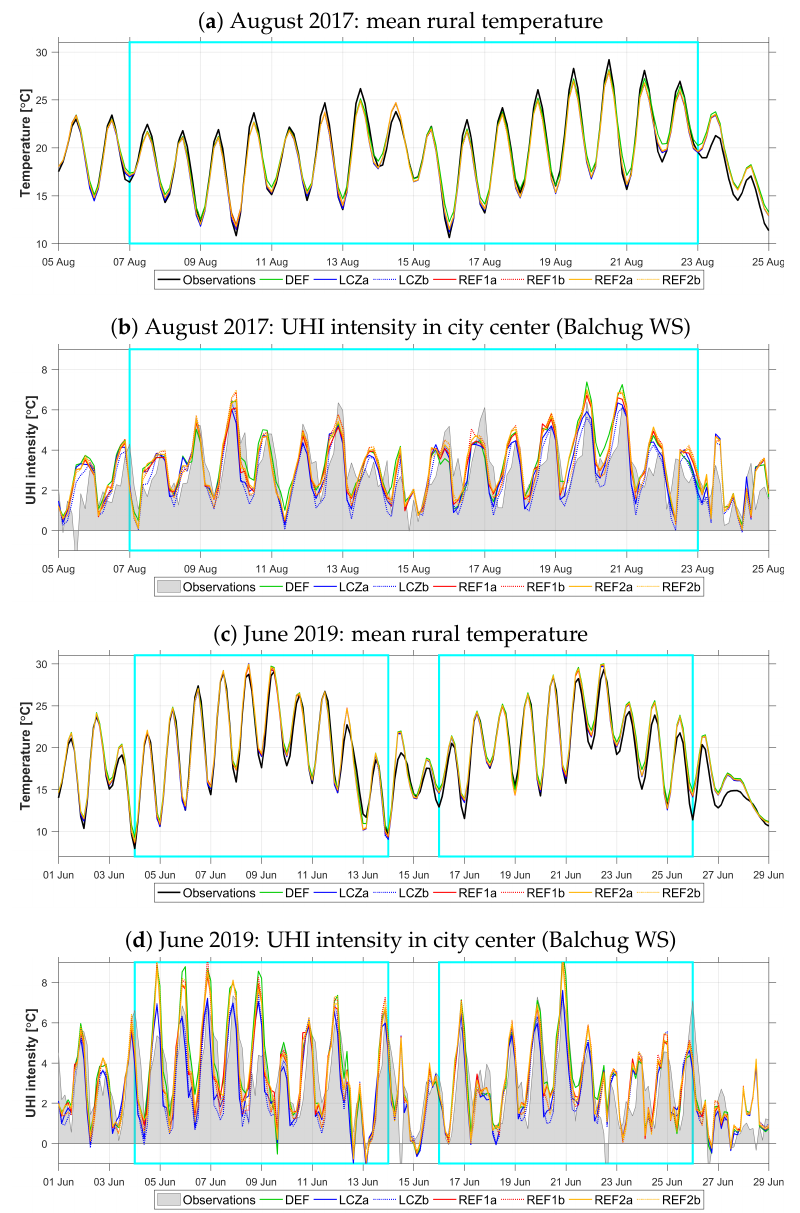
Figure 7. Modelled and observed values of the mean rural temperature ( a , c ) and urban heat island (UHII) intensity for the city center ( b , d ) for August 2017 ( a , b ) and June 2019 ( c , d ). The mean rural temperature is averaged over 9 selected rural stations around Moscow, and UHI intensity is defined as the departure from this mean rural temperature. Cyan rectangles indicate the sub-periods selected for the analysis of the diurnal and spatial variations of the temperature and UHI